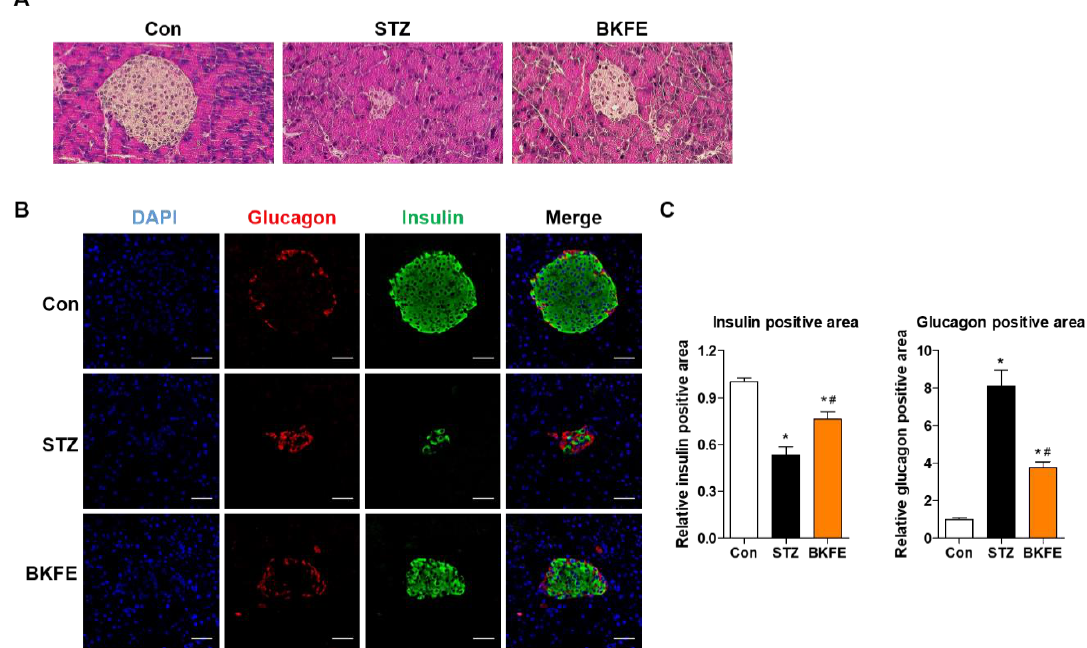
Figure 2. BKFE reduces beta cell damage in STZ-induced diabetic mice. Histological analysis of pancreas sections. ( A ) Representative images showing the islets by hematoxylin and eosin (H and E) staining (original magnification, 200×). ( B ) Representative images showing the expression of insulin (green) and glucagon (red) by immunofluorescence staining. The nuclei were counterstained with 4 (cid:48) ,6-diamidino-2-phenylindole (DAPI) (blue). (Scale bars, 50 µ m). ( C ) Relative insulin- and glucagon-positive areas were quantified using the ImageJ software. Data are presented as mean ± SEM ( n = 5). * p < 0.05 vs. Con; # p < 0.05 vs. STZ; Con, Vehicle-treated non-diabetes; STZ, Vehicle + STZ; BKFE, BKFE +